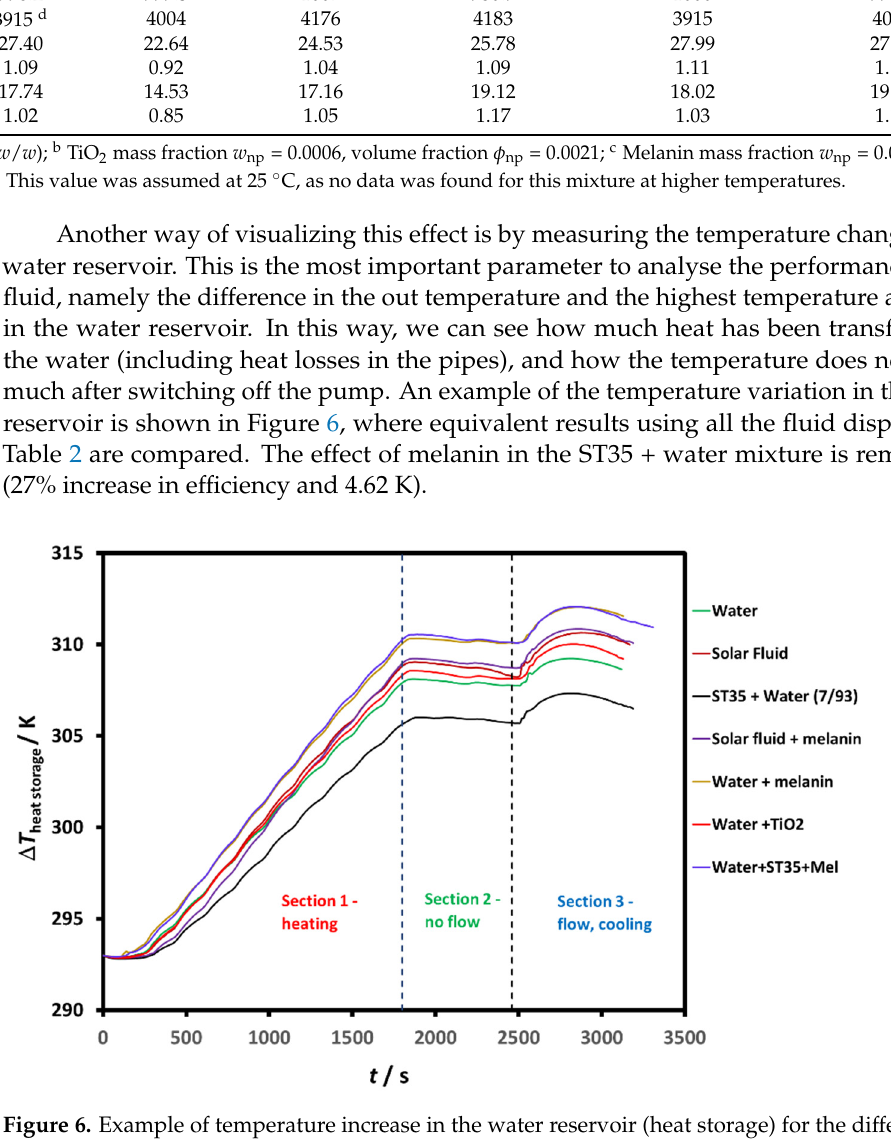
Figure 6. Example of temperature increase in the water reservoir (heat storage) for the different heat transfer fluids used in this study. ∆ T heat storage = T max − T min .